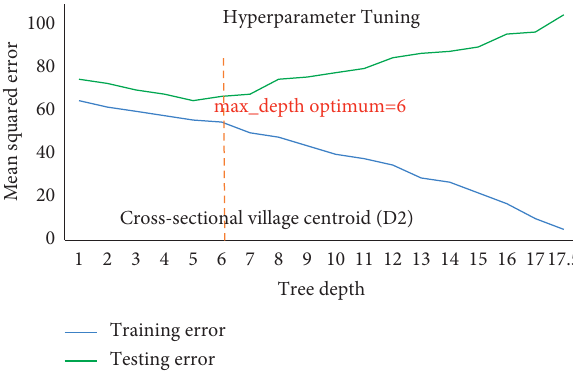
Figure 9: Hyperparameter tuning of DTR for D1. Figure 10: Hyperparameter tuning of DTR for D2.